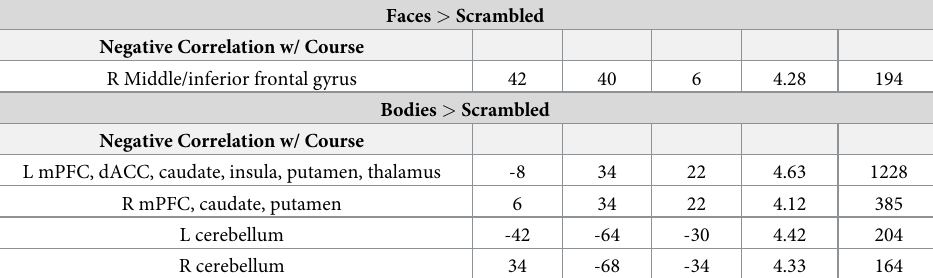
Table 5. Regions of activation associated with illness course � across the whole brain.